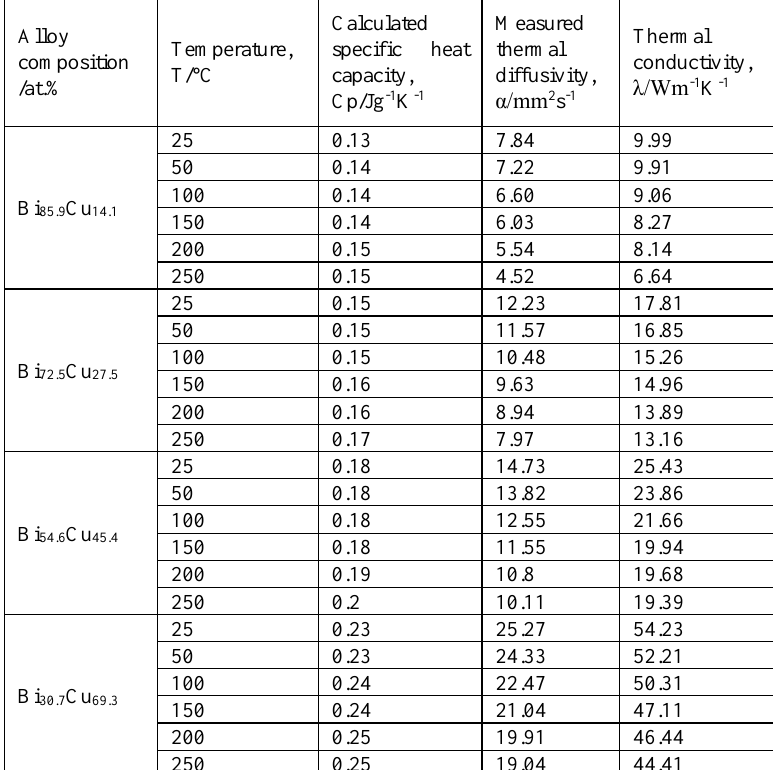
Table 4. Specific heat capacity, thermal diffusivity, and thermal conductivity of the investigated Bi–Cu alloys in the temperature range 25-250